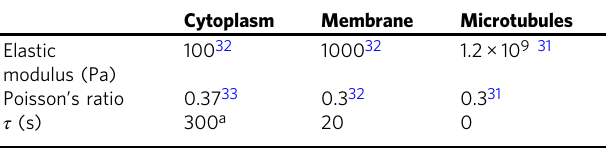
Table 1 Material properties of the cellular components.